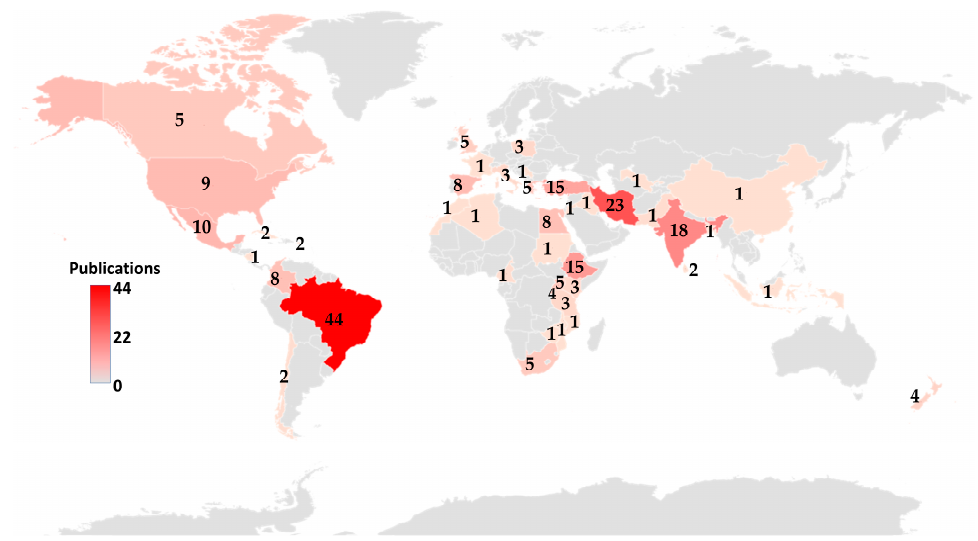
Figure 5. The number of publications included in the study per country (Basic map: © Copyright: Australian Bureau of Statistics, GeoNames, Microsoft, Mavinfo, TomTom, Wikipedia).